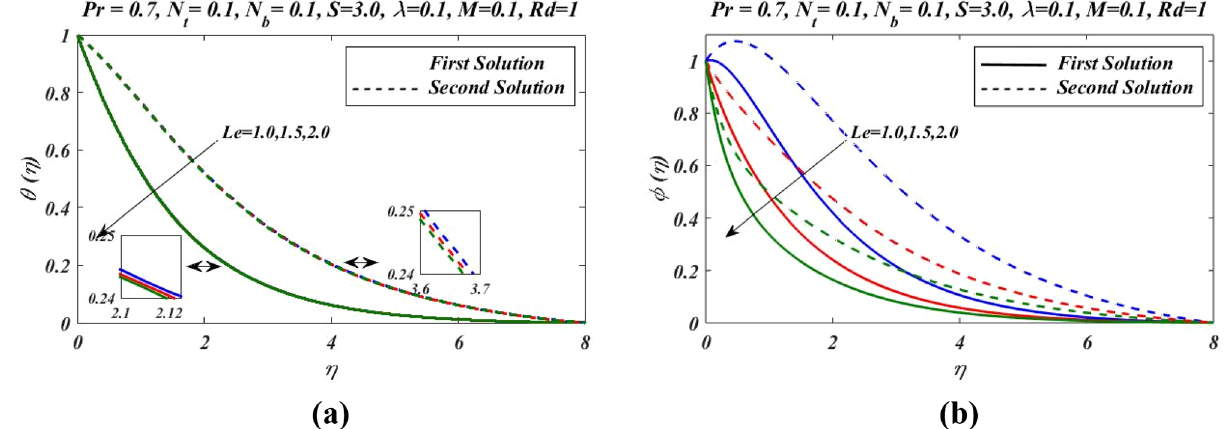
Figure 5. Outcomes of Le on ( a ) temperature and ( b ) nanoparticles volume fraction.